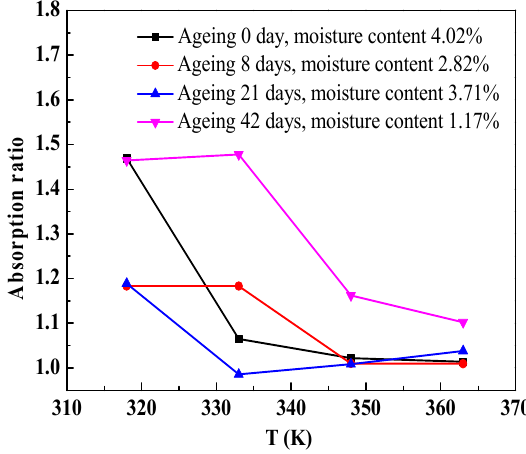
Figure 13. Relations between absorption ratio and absolute temperature T .